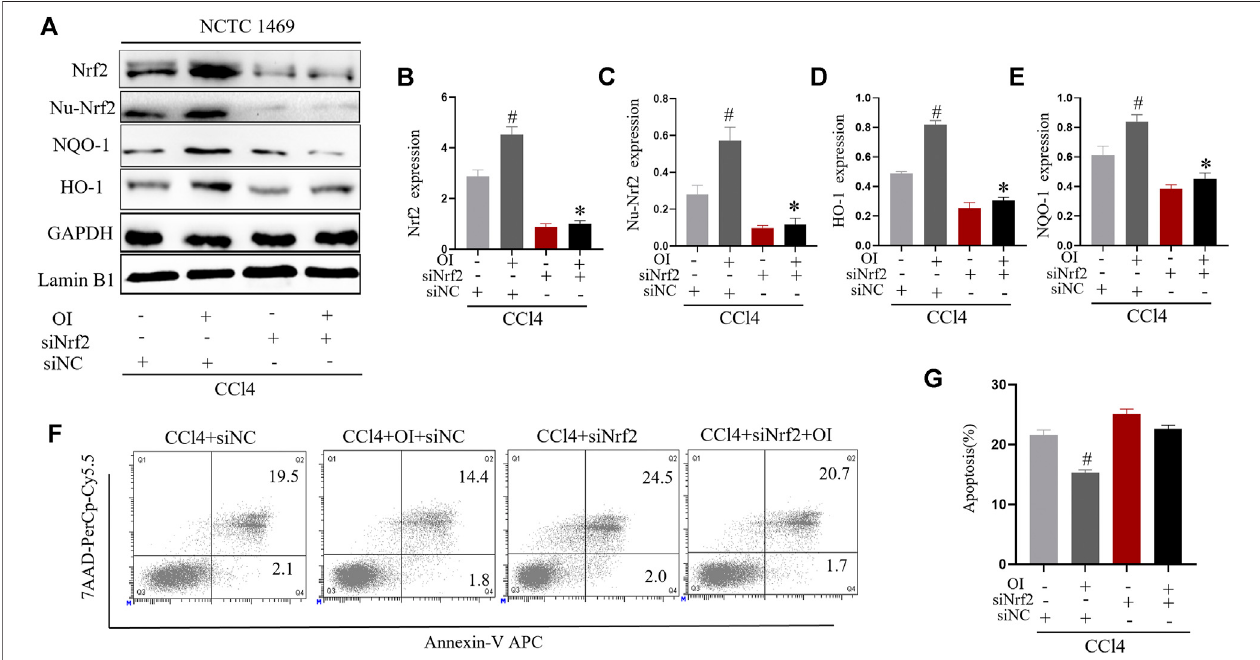
FIGURE6| Nrf2 knockdownattenuatedtheprotectiveeffectofOIinCCl4-treatedNCTC1469cells. (A) RepresentativeimmunoblotimagesofNrf2,Nu-Nrf2,HO-1, andNQO-1inCCl4-treatedNCTC1469cellswithsiRNAcontrol(siNC)orsiRNA Nrf2 (siNrf2)treatment. (B) ImmunoblotanalysisoftotalNrf2expressionineachgroup. (C) Immunoblot analysis of nucleus Nrf2 (Nu-Nrf2) expression in each group. (D) Immunoblot analysis of HO-1 expression in each group. (E) Immunoblot analysis of NQO-1 expression in each group. (F) The death of NCTC 1469 cells was measured by fl ow cytometry, and apoptosis rates was statistically analyzed (G) for each group. GAPDHandLaminB1wereusedasanendogenouscontrol.Dataareexpressedasmean ± SEM.Allexperimentswereperformedthreetimesindependently.# p < 0.05vs. siNC + CCl4 group; * p < 0.05 vs. OI + siNC + CCl4 group.